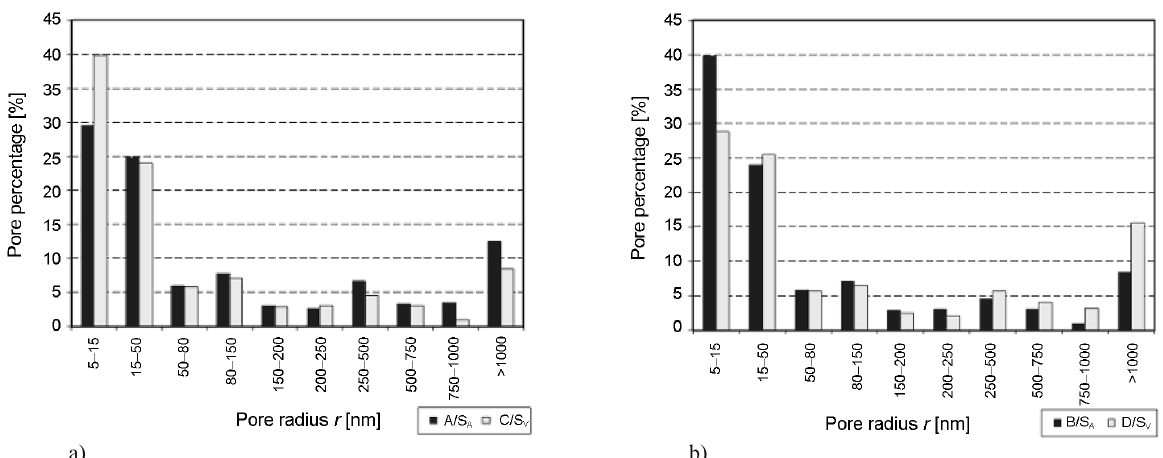
Fig. 5. Pore percentage for adopted radius intervals in pore radius range of 5–7500 nm for compared concretes: a) A/S A and C/S V ; b) B/S A and D/S